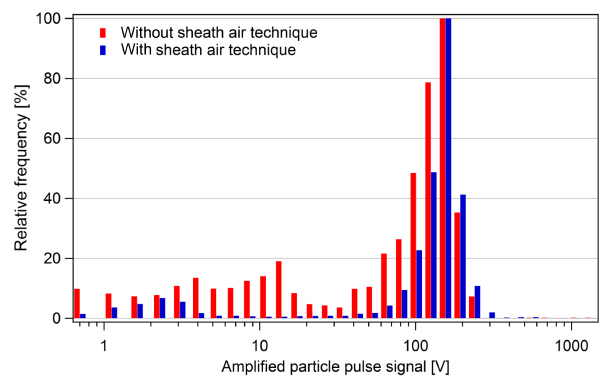
Figure 5. Signal intensity distribution measured with the CARIBIC OPSS for 350nm PSL particle without and with implemented sheath air